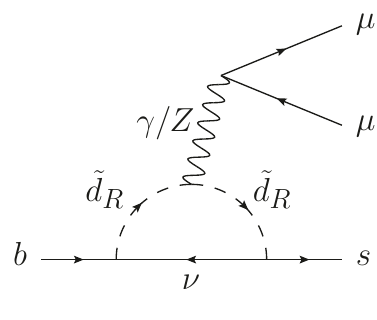
Figure 3 . An example penguin diagram for b ! s(cid:22)(cid:22)